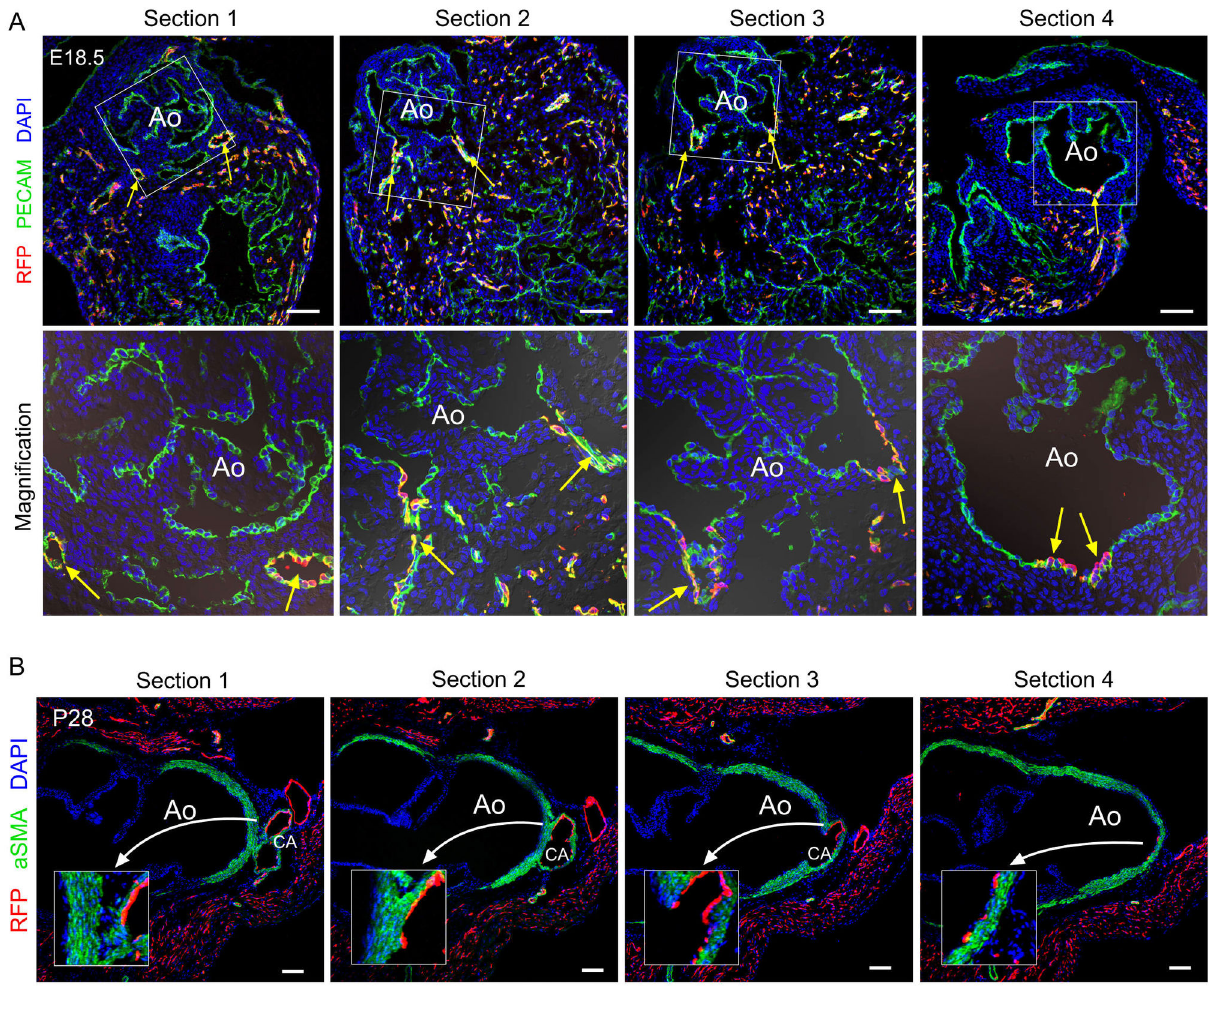
Figure 5. Apln+ peritruncal endothelial cells contribute to endothelia of coronary orifice. ( A ) Immunostaining of RFP and PECAM on serial sections (section 1 to 4) of E18.5 AplnCreERT2/+;Rosa26RFP/+ heart. Yellow arrows indicate labeled endothelial cells in coronary artery trunk and orifice, which are derived from Apln+ coronary endothelial cells. Tamoxfien was injected at E10.5. Serial sections were taken at 50 um intervals. ( B ) Immunostaining of aSMA (green) and genetic marker RFP (red) on serial sections (section 1 to 4) of P28 AplnCreERT2/+;Rosa26RFP/+ heart. Nuclei were stained with DAPI. Tamoxifen was administered at E10.5. Serial sections were taken at 50 um intervals. Inserts show magnified views of the coronary artery connection to aorta. Ao, aorta; CA, coronary artery. White bar = 100 um.